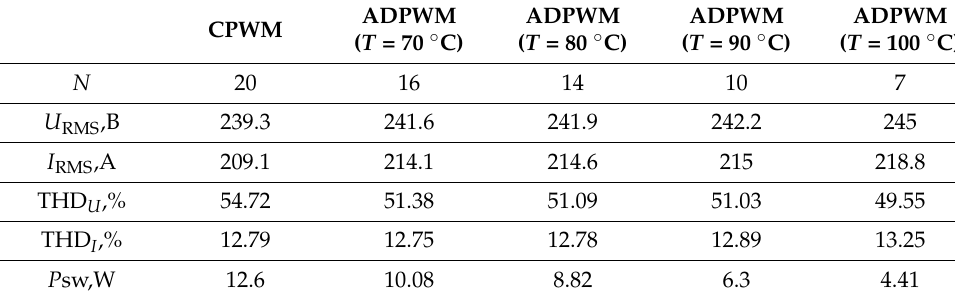
Table 1. Simulation results comparing CPWM and proposed ADPWM method.